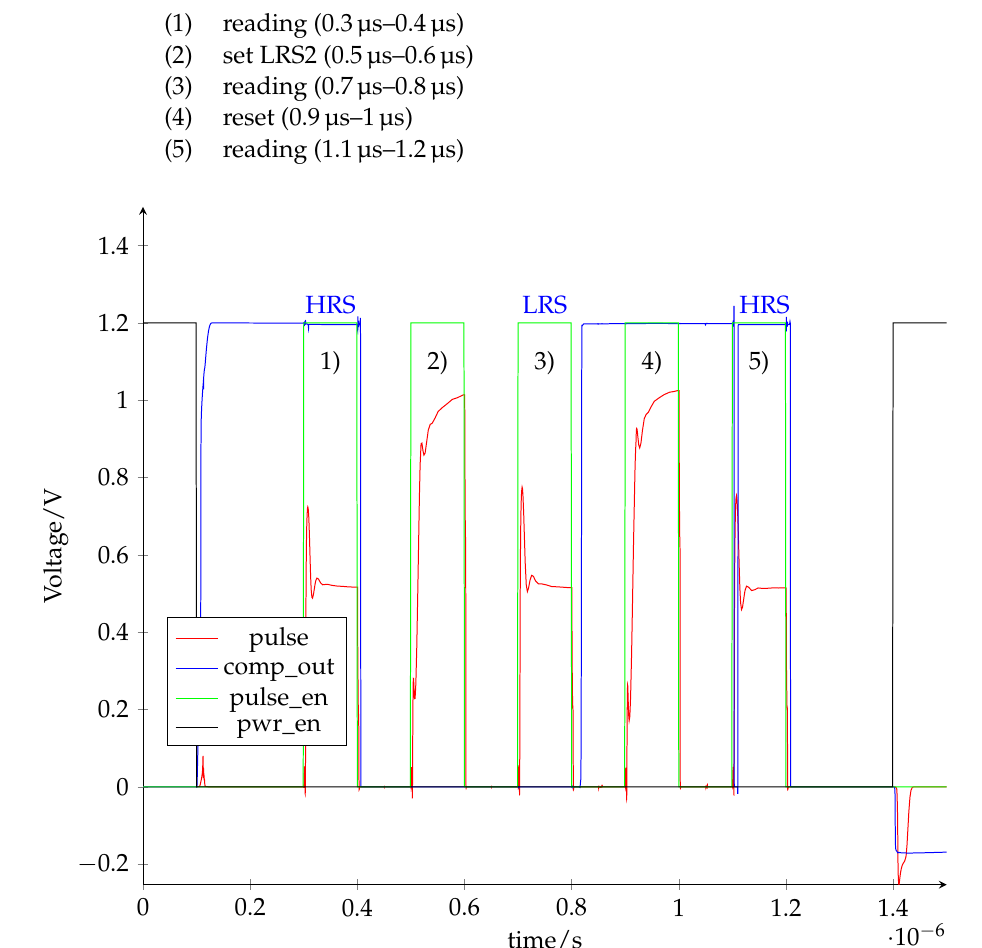
Figure 8. System simulation of a set and reset operation with read operations in between to evaluate the cell state. The comp_out signal (blue) is used to read the cell status and determines, in this case, if the cell is in either HRS, if comp_out is on high level, or one of the LRS, if comp_out is on low level. The signal is not valid during a set or reset